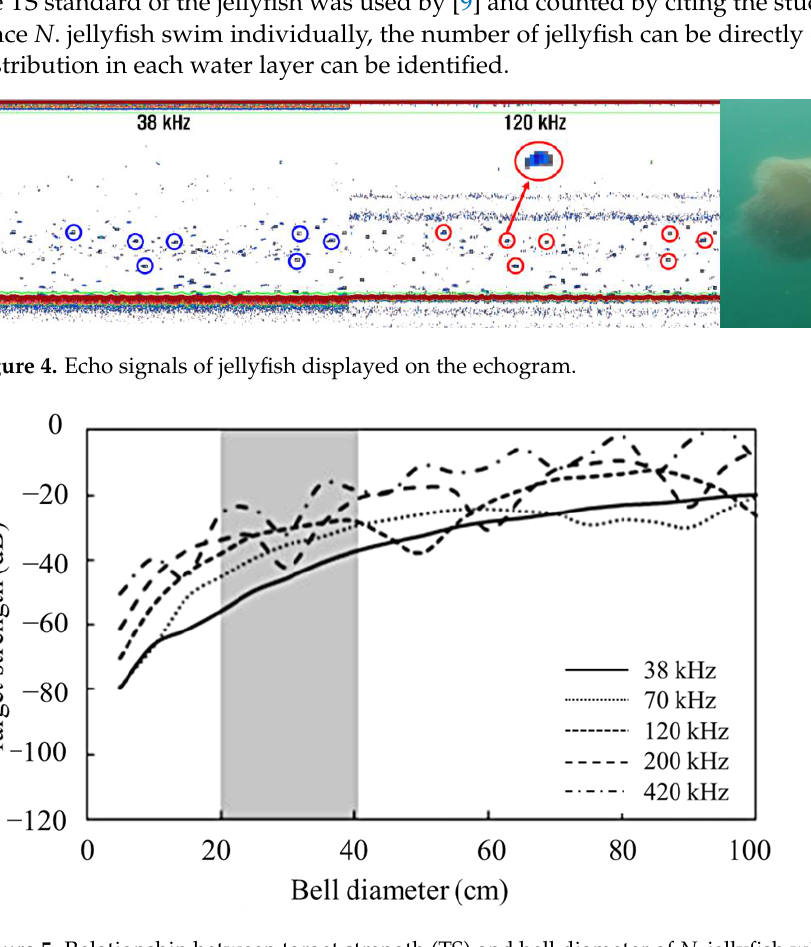
Figure 5. Relationship between target strength (TS) and bell diameter of N. jellyfish with tilt angle 38, 70, 120, 200, and 420 kHz at 38, 70, 120, 200, and 420 kHz [9]. Count of Jellyfish ′ s individual ÷ Log distance (ind. nmi⁄ )